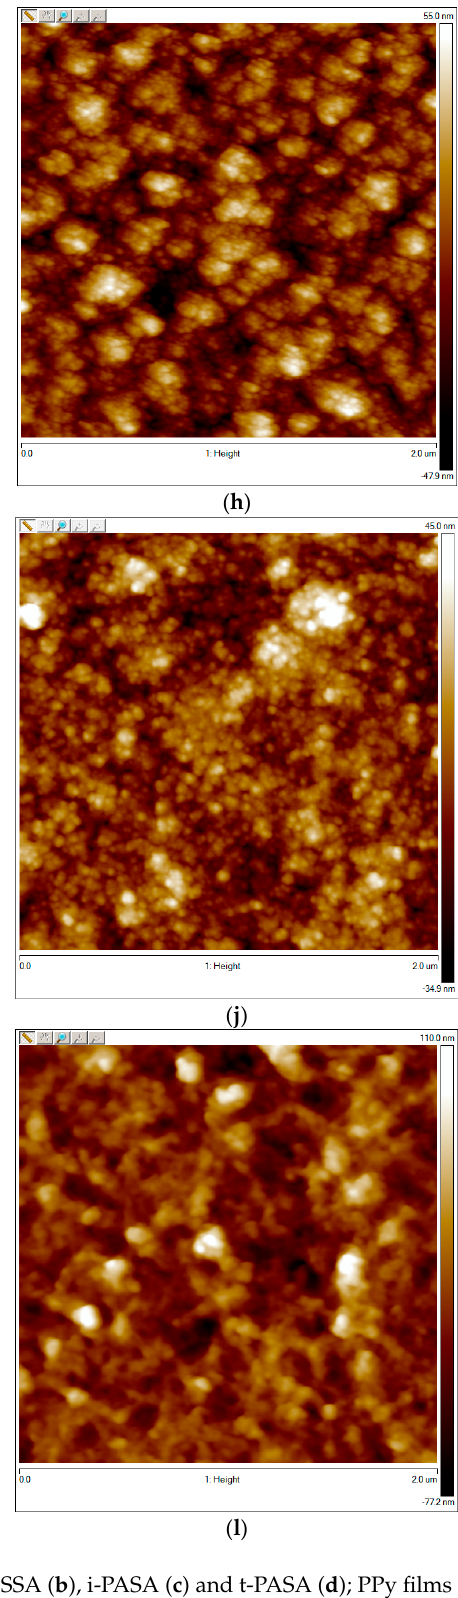
Figure 6. AFM images of PEDOT films obtained in PAMPSA ( a ), PSSA ( b ), i-PASA ( c ) and t-PASA ( d ); PPy films obtained in PAMPSA ( e ), PSSA ( f ), i-PASA ( g ) and t-PASA ( h ); and PANI films obtained in PAMPSA ( i ), PSSA ( j ), i-PASA ( k ) and t-PASA ( l